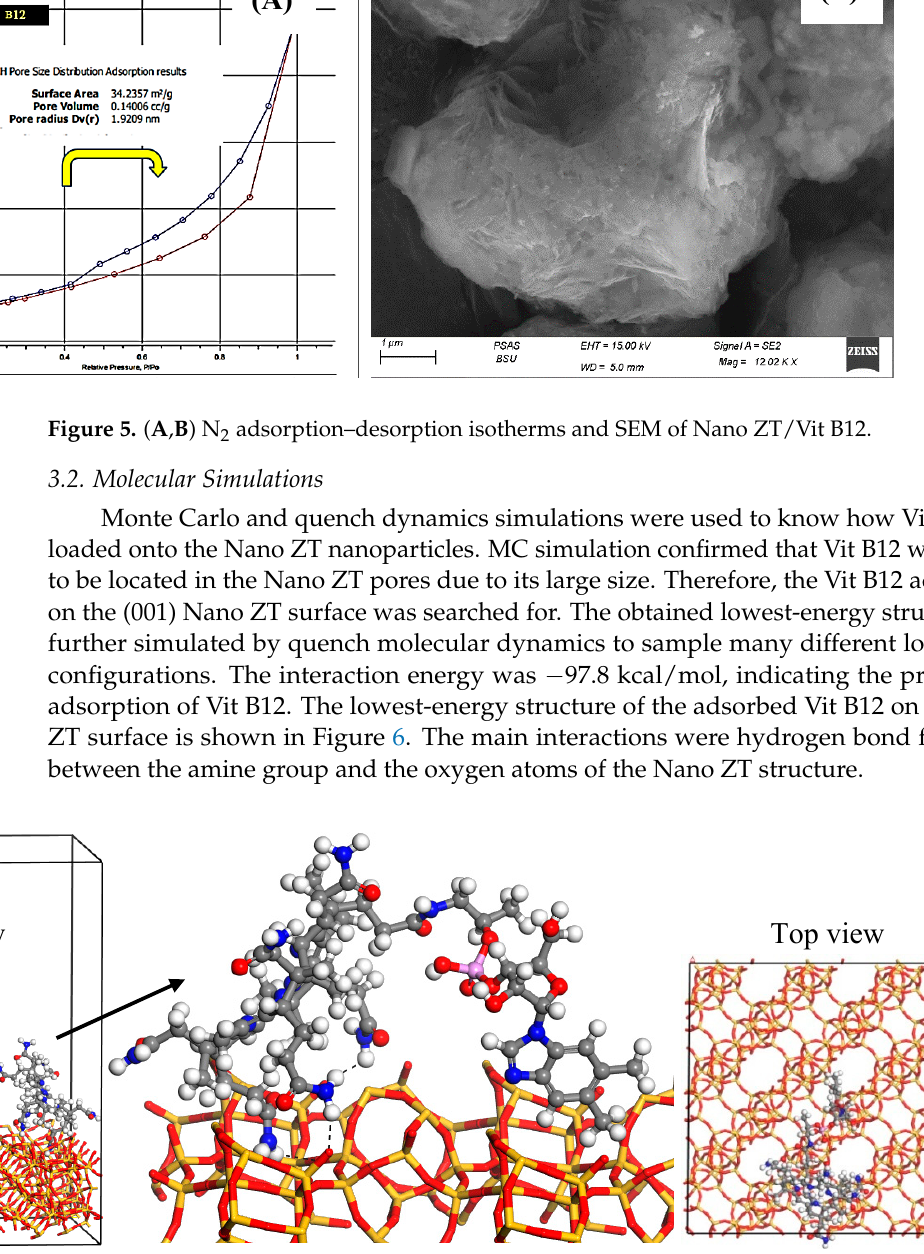
Figure 6. The lowest-energy structure of the adsorbed Vit B12 on the (001) Nano ZT surface, as obtained from the quench dynamics simulation. The atom colors: silicon ( yellow ), oxygen ( red ), nitrogen ( blue ), carbon ( grey ), phosphorus ( pink ), and hydrogen ( white ). The dashed black lines are the hydrogen bonds.